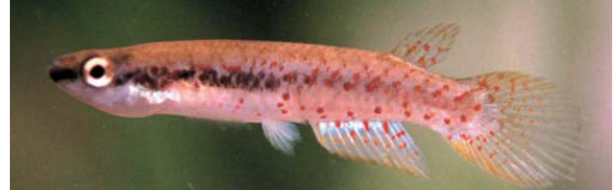
gion and ventral surface of head white. Lower jaw dark gray. Iris light yellow. Dorsal fin pale yellow with 5-7 oblique dark gray bars, and dark gray distal stripe. Anal fin light blue with 6-8 oblique dark red bars, and dark gray distal stripe. Caudal fin white with 3-5 dark gray bars or vertical rows of spots; dark gray zone along fin margin; two round black spots vertically arranged on basal portion, not contacting fin margin. Paired fins hyaline; anterior margin of pelvic fin dark